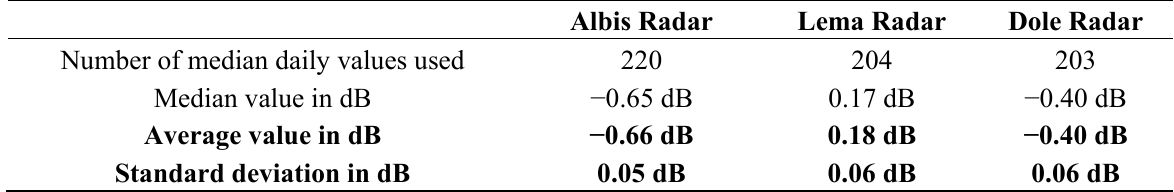
Table 4. Daily agreement between the horizontal and vertical channel Sun measurements. Albis